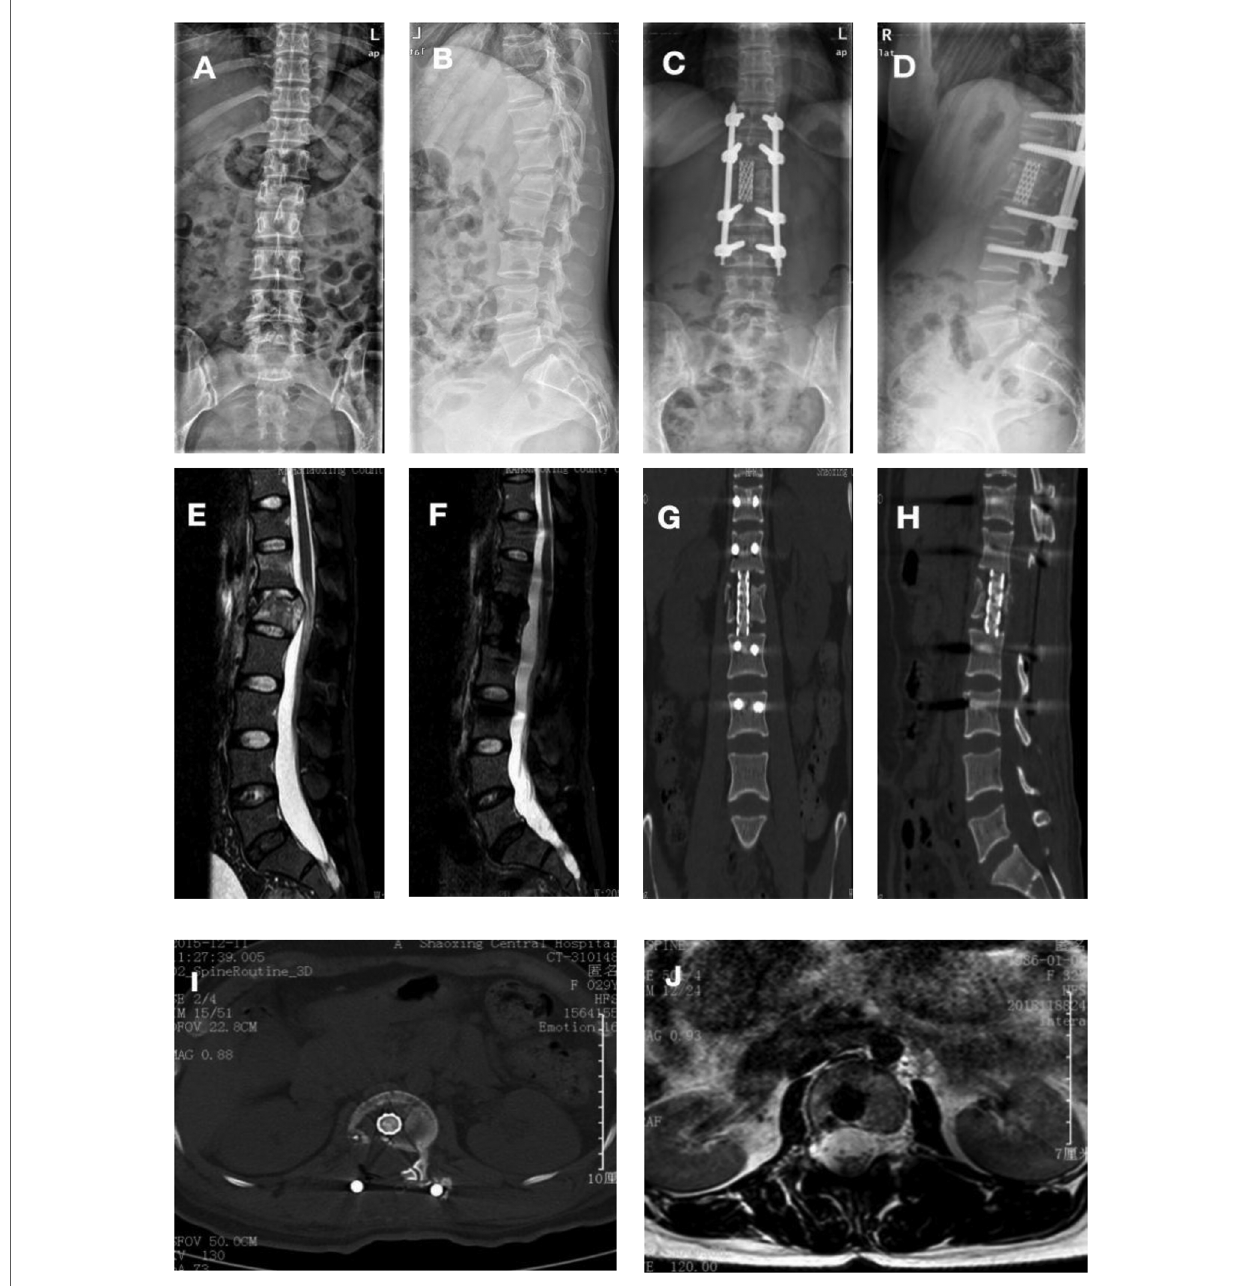
FIGURE 1 Typical preoperative, postoperative, and follow-up images of severe thoracolumbar burst fractures with posterior midline spinal approach for spinal canal limited decompression and 13-mm titanium mesh implantation (case #1). ( A,B ) True lateral x-rays of the patient ’ s thoracolumbar spine before the operation shows the L1 fracture. ( C,D ) True lateral x-rays of the thoracolumbar vertebrae after the operation showing good fi xation and recovery of the height of the anterior edge of the L1 vertebra itself. ( E ) Preoperative magnetic resonance imaging (MRI) shows L1 burst fracture, spinal cord compression, and obvious spinal canal occupancy. ( F – J ) Postoperative MRI indicates no spinal cord compression and no spinal canal occupancy. ( G – I ) Postoperative computed tomography (CT) indicates a good position of the titanium mesh, screws, and titanium rods and good bone graft fusion. ( H ) Thoracolumbar CT after the removal of titanium rods and